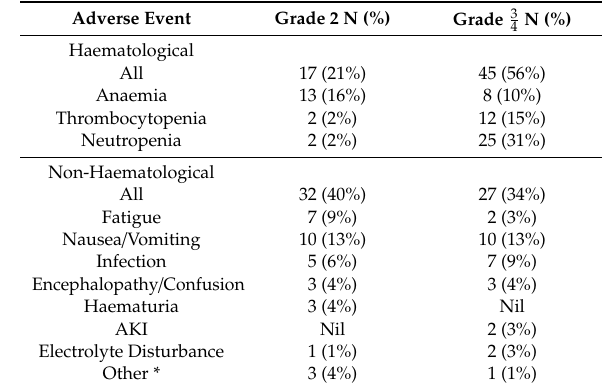
Table 3. Rates of CTCAE v.4.0 G ≥ 2 haematological and non-haematological adverse events in patients treated with at least one cycle of infusional ifosfamide (n =